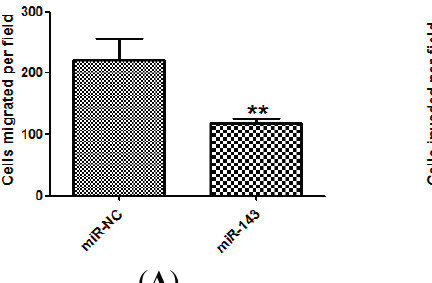
Figure 3. miR-143 suppresses migration and invasion of NSCLC cells. The migration ( A ) and invasion assays ( B ) of NCI-H23 cells transfected with miR-143 or miR-NC. Experiments were performed in triplicate. * p < 0.05, ** p < 0.01 compared with